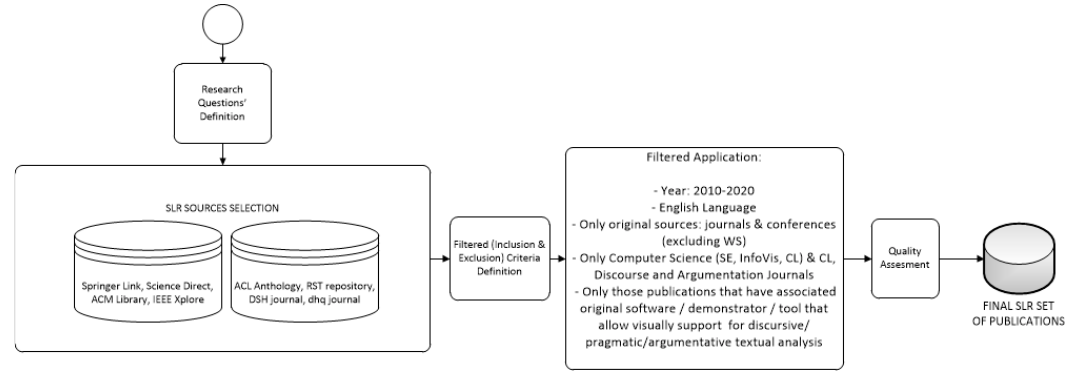
Figure 1. Systematic literature review (SLR) process steps, inspired by the Kitchenham and Charters guidelines (2007) [4].